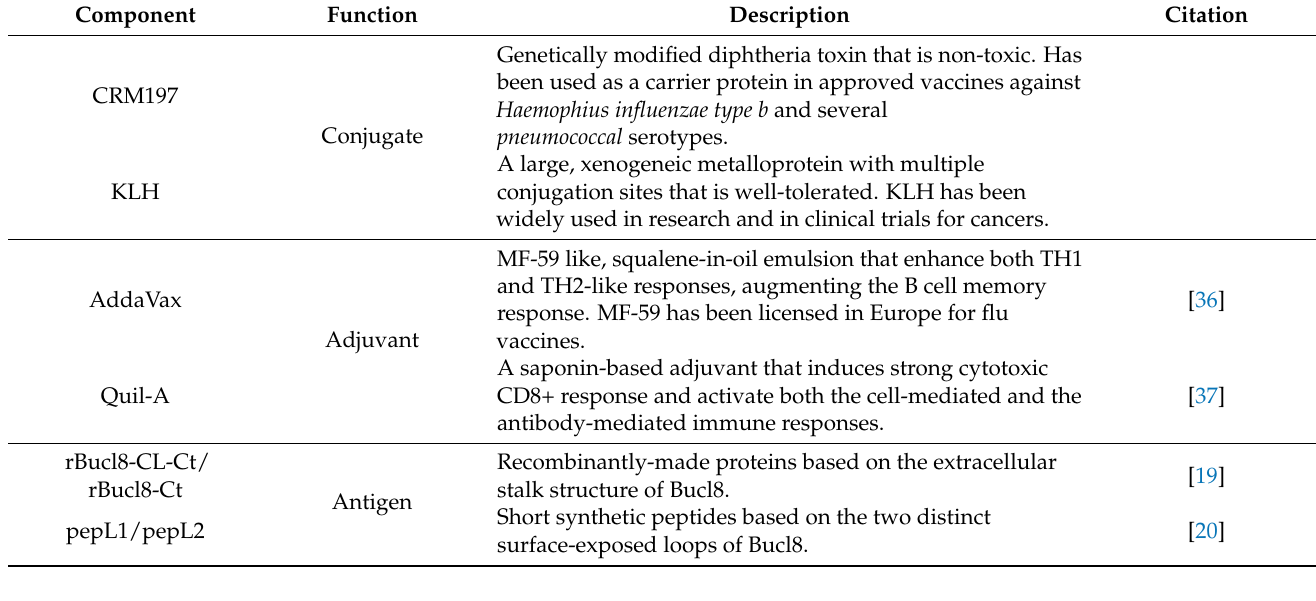
Table 4. Vaccine components.